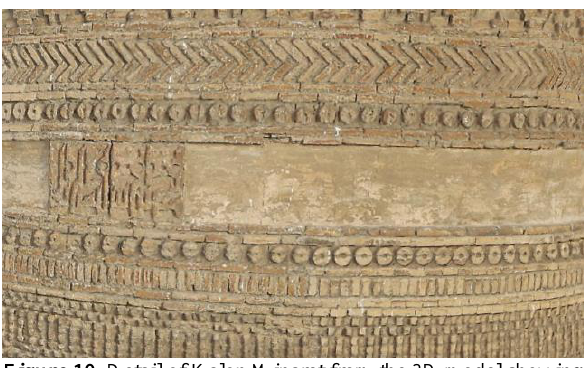
Figure 10 . Detail of Kalon Minaret from the 3D model showing missing parts. Source: authors.